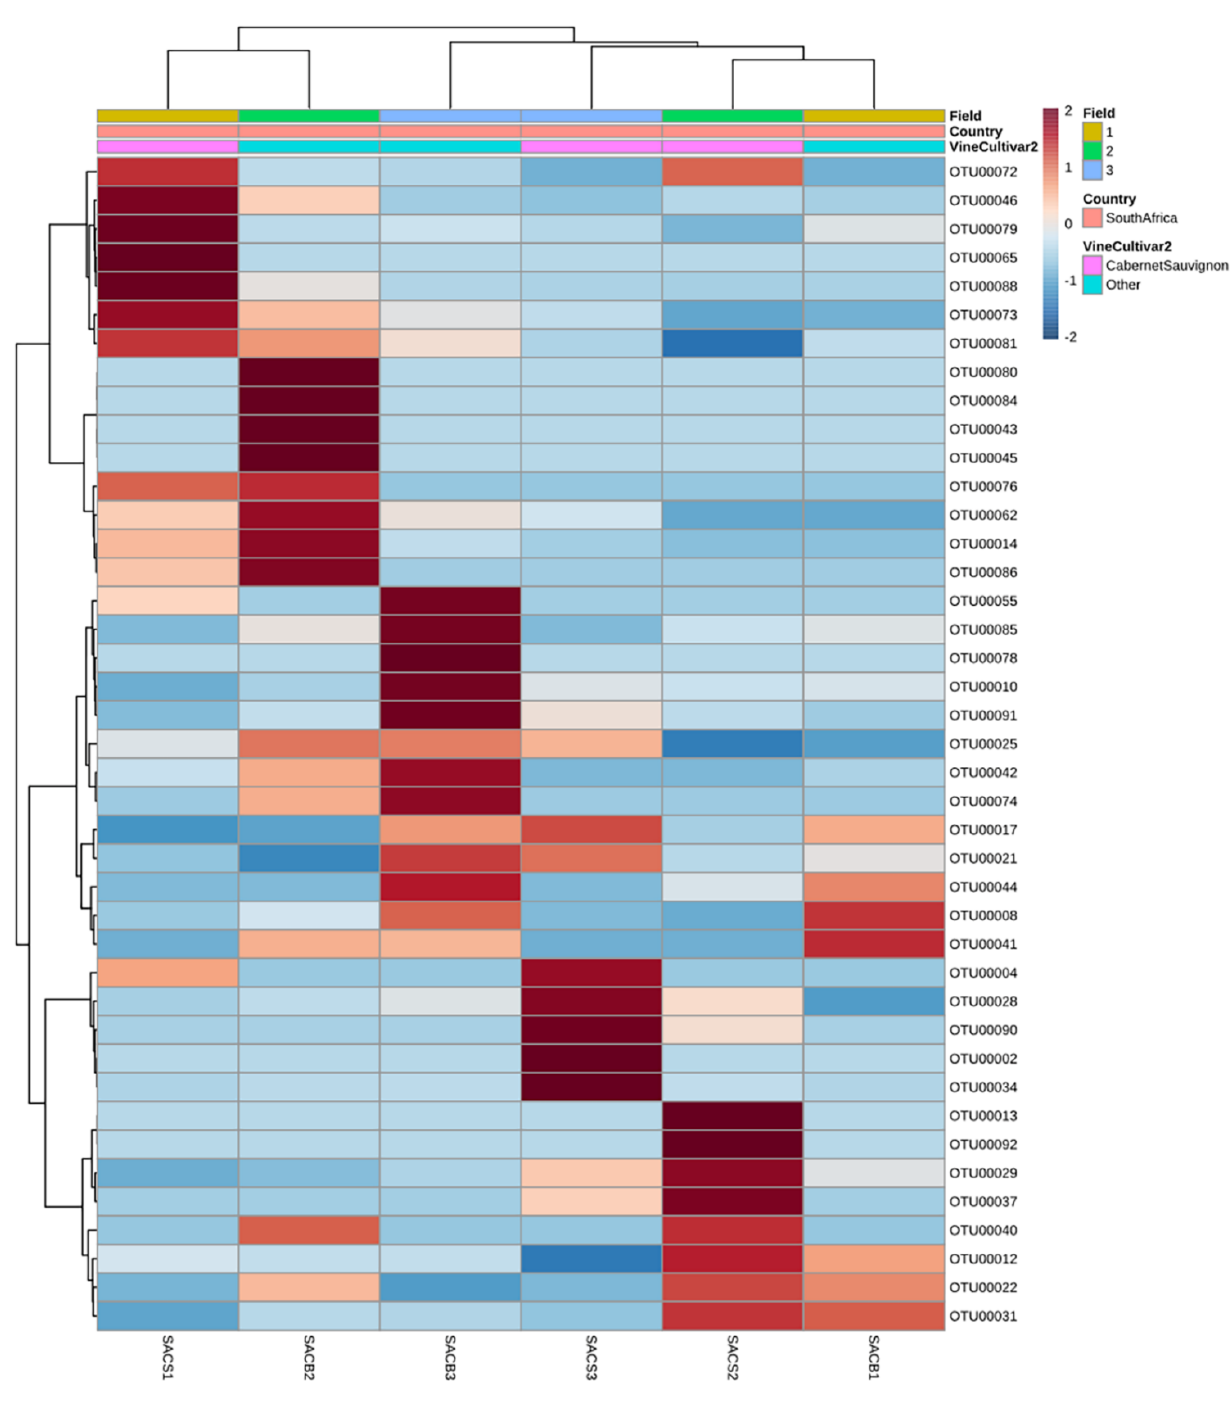
Figure A8. Clustered heatmap showing the variation of taxonomic abundance with regard to South Africa (country) and cultivar samples [Cabernet Sauvignon and others (local cultivar)]. Sample code: SA, South African; C, Cabernet Sauvignon; CB, Chenin Blanc.